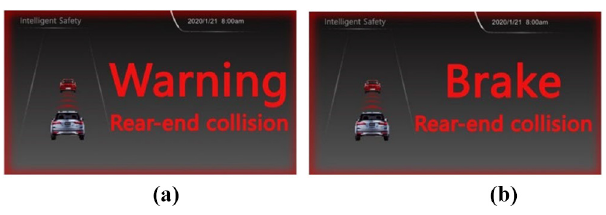
Figure 5 FCW information content design